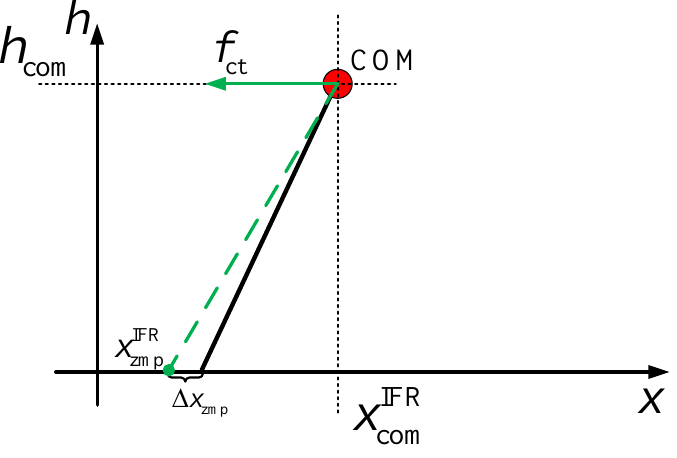
Figure 5. Model of the linear inverted pendulum (LIP) of the robot’s turning walk in the x